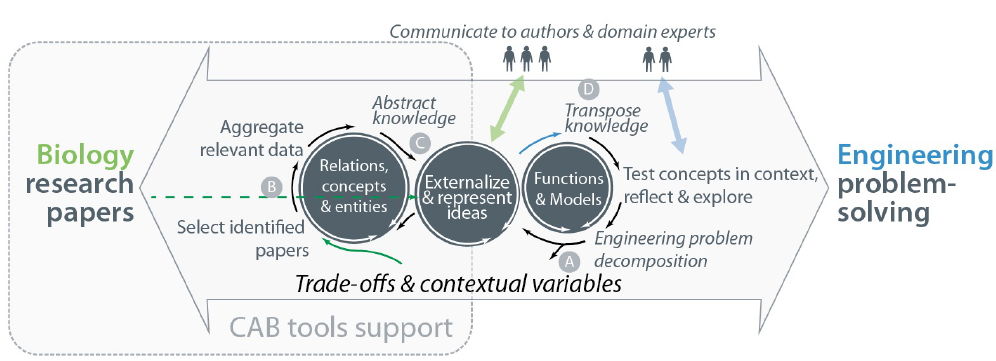
Figure 5. Overview of the holistic, iterative approach that may be supported by a Computer-Aided Biomimetics (CAB) tool. Steps may follow each other in nondeterministic order. One possible route through a CAB: (A) Define an engineering problem as a trade-off, enabling an initial search for